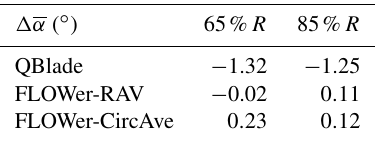
Table 12. Differences between the experiment and the different simulation results of the angle of attack for